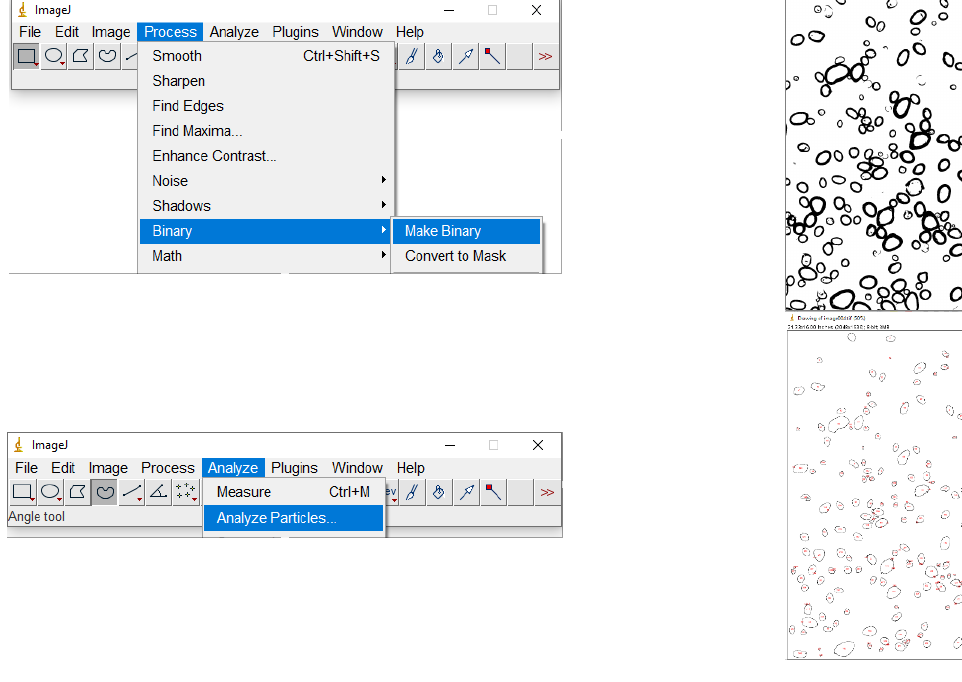
Figure 1. Diagram of the actions performed in ImageJ and their results.